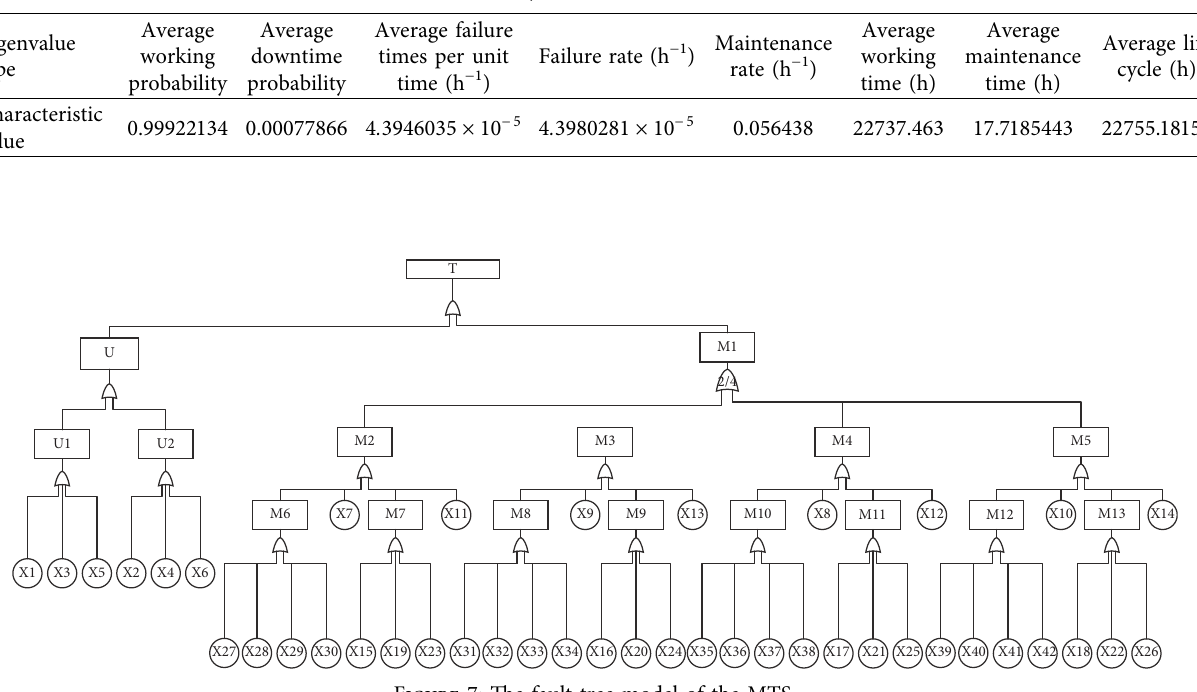
Table 13: Reliability characteristic value of the